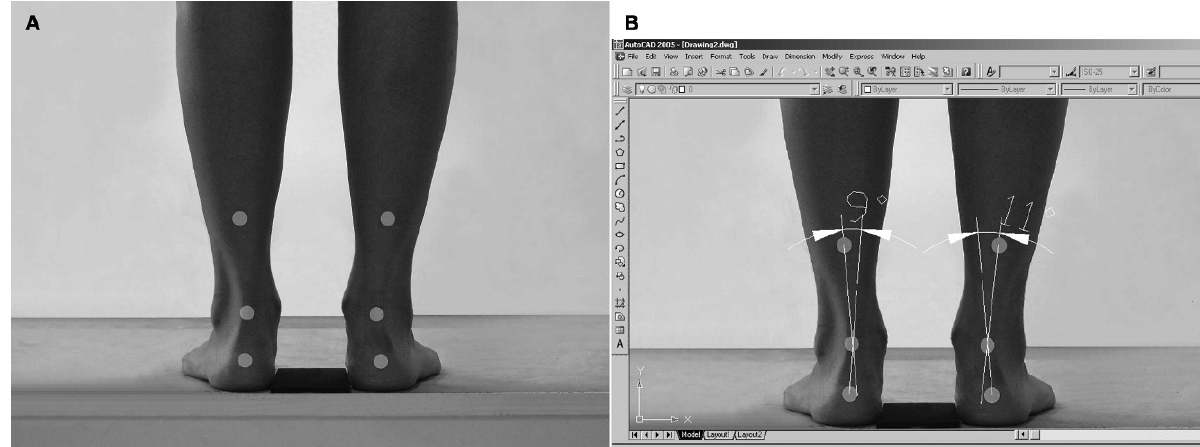
Figure 1 - Positioning of the markers (A) and quantification methods of rearfoot alignment